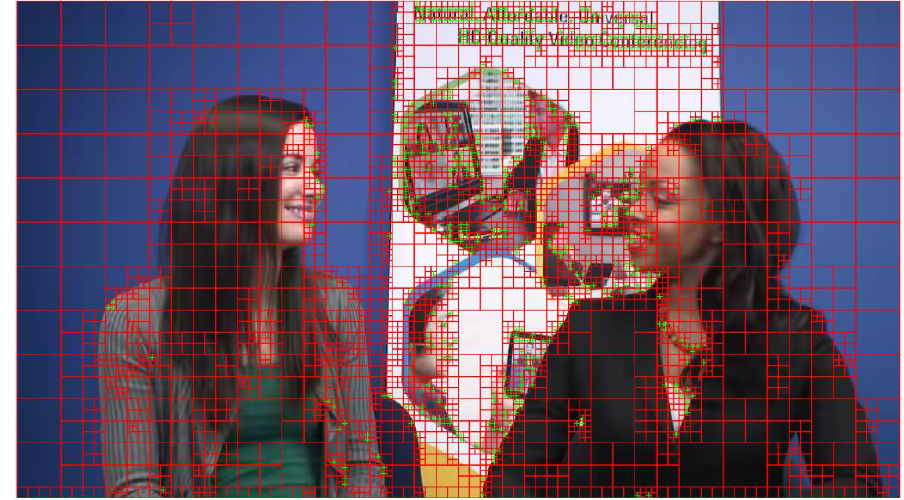
Figure 1. Coding Unit (CU) partitioning structure for a typical intra-predicted frame in “Kristen and Sara”